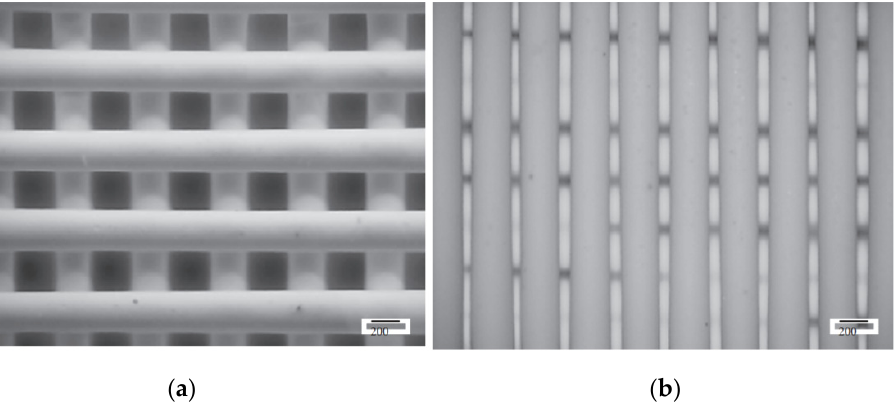
Figure 33. Microscopic images of zirconia lattices printed via freeform extrusion, with ( a ) 300 μ m and ( b ) 70 μ m size pores. Here, the scale bar is 200 μ m [158].